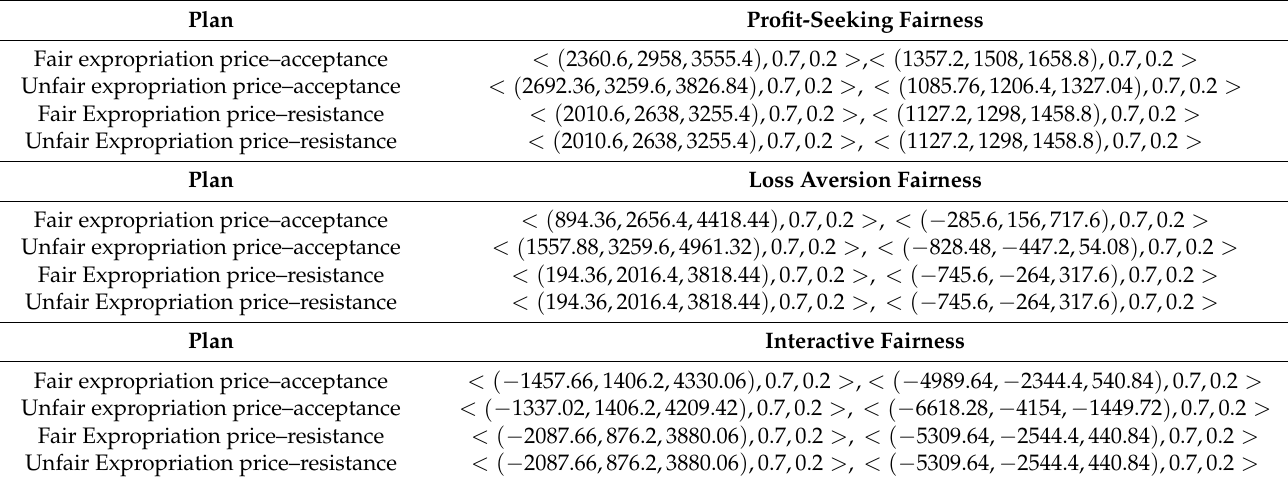
Table 5. Multidimensional fuzzy equilibrium evaluation matrix of the case. Plan Profit-Seeking Fairness